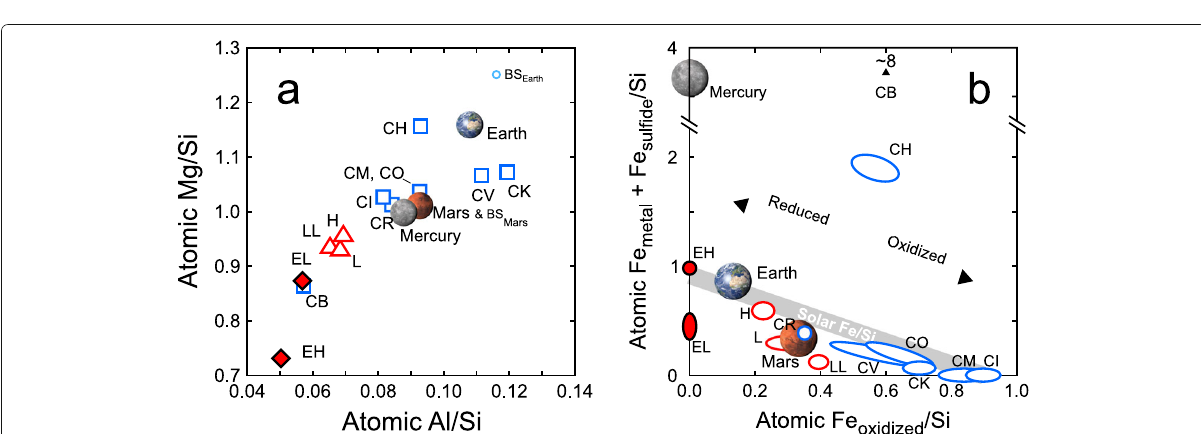
Fig. 2 Ratios of major cations in the terrestrial planets and chondrites. a Magnesium/Si versus Al/Si. b Abundances of reduced (metal and sulfide) and oxidized Fe normalized to Si. Data sources are as in Fig. 1 and Urey and Craig (1953). Red symbols identify the inner solar system, NC chondrites; see text for details. The Si-bearing core results in a Bulk Silicate Mercury that plots off scale at Al/Si (0.143) and Mg/Si